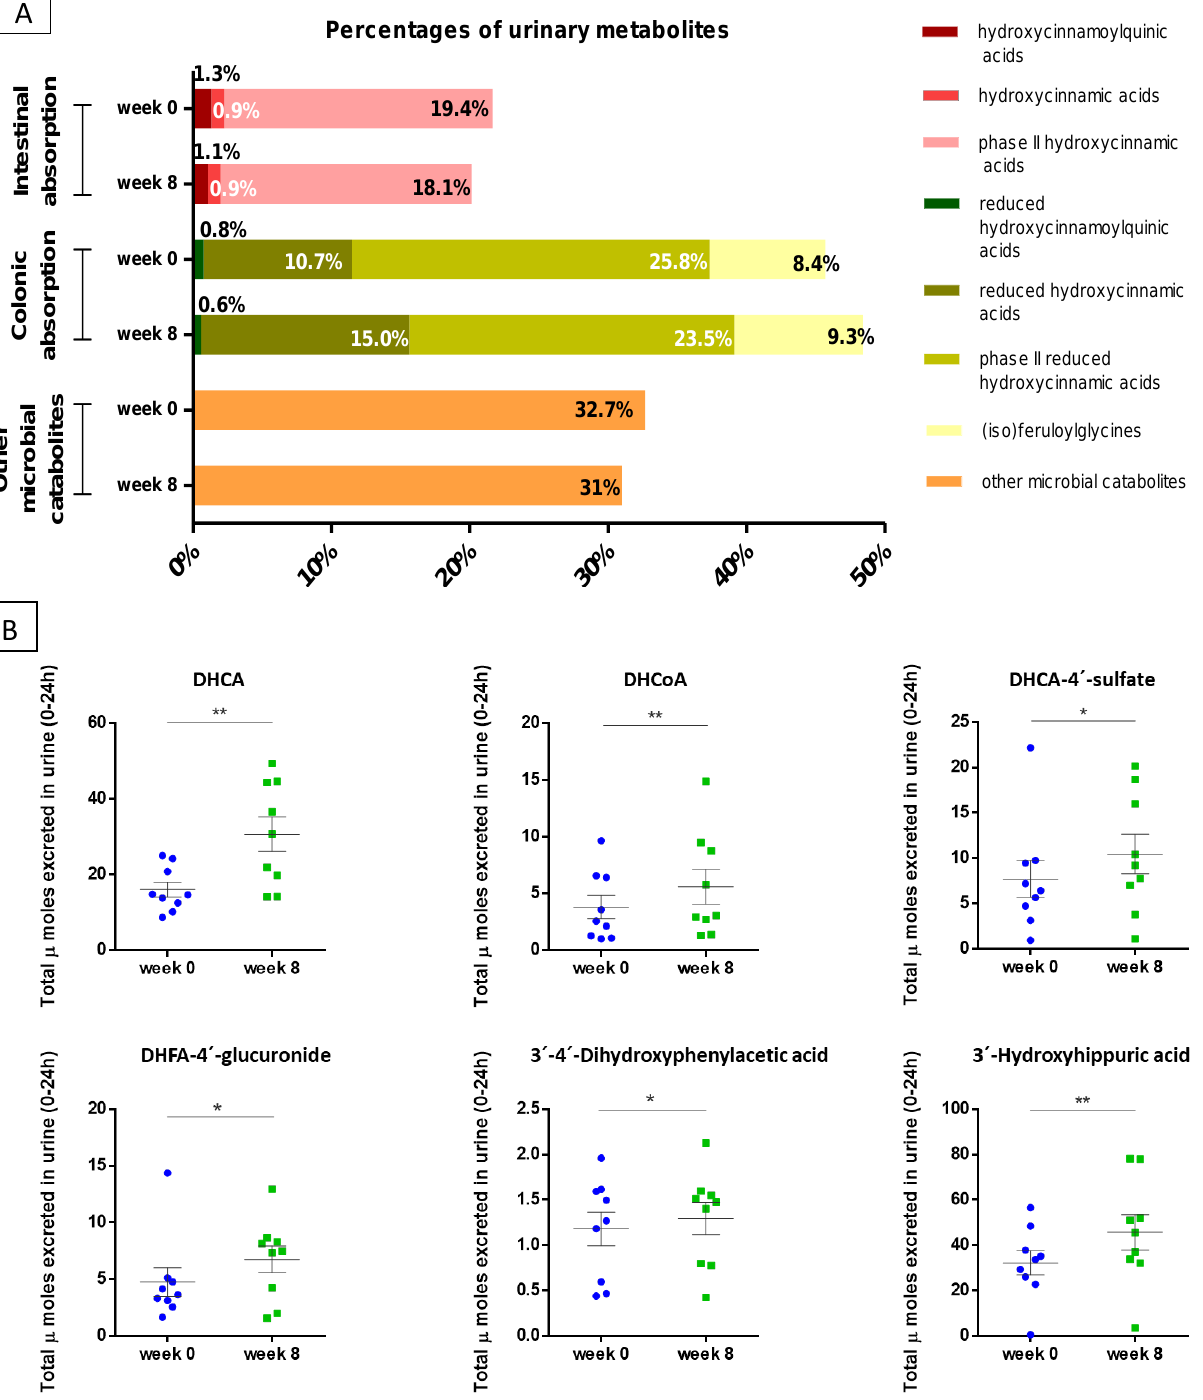
Figure 3. 24-h cumulative urinary excretion represented as (A) Percentages of the main groups of phenolic metabolites identified, and (B) Selected metabolites with significant increases in their excretion at the beginning (week 0) and after 8 weeks consuming the GCPE nutraceutical. DHCA: Dihydrocaffeic acid; DHCoA: Dihydrocoumaric acid; DHCA-4´-sulfate: 3-(3´-Hydroxyphenyl)propanoic acid-4´-sulfate; DHFA- 4´-glucuronide: 3-(3´-Methoxyphenyl)propanoic acid-4´-glucuronide. Values are means ± SEMs (n=9). * p < 0.05 ** p < 0.01 week 0 vs. week 8. Reduced forms of hydroxycinnamic acids (DHCA, DHFA, DH i FA, 3-(4 (cid:48) -hydroxyphenyl) propanoic acid ( Dihydrocoumaric acid , DHCoA ), and dihydrodimethoxycinnamic acid),